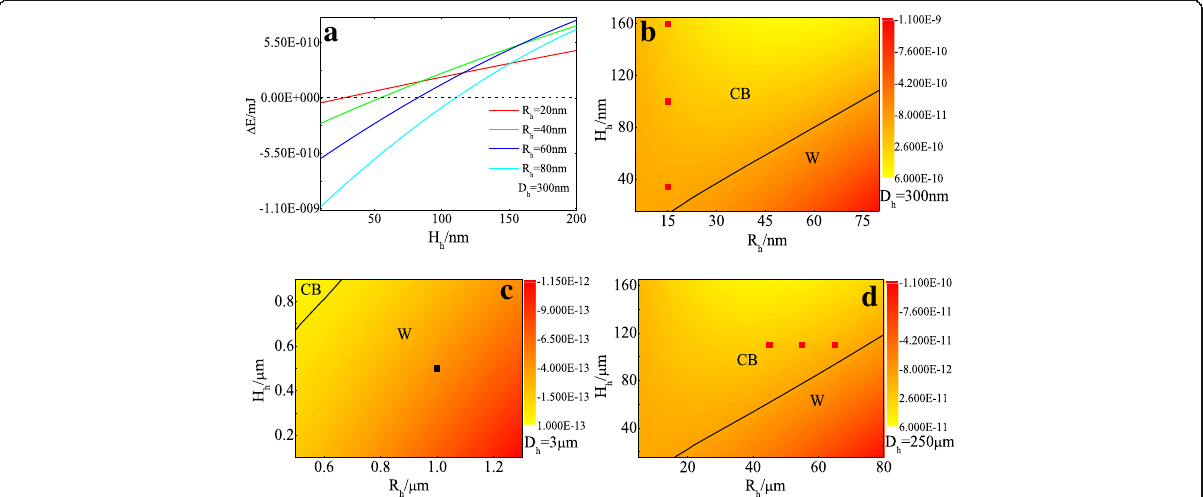
Fig. 4 The free energy difference between the W and CB states as the function of hole height H h under different nanohole radii ( a ). b – d are phase diagrams of wetting states of the water droplet on hole-patterned surfaces. In each panel , the inserted square dots represent experimental measurements compared with our model and the black line delineates the division between the W and CB states. Hole spacing of center-to-center D h =300 nm, experimental data from Ref. 35 ( b ); D h =3 nm, experimental data from Ref. 36 ( c ); D h =250 nm, experimental data from Ref. 37 ( d